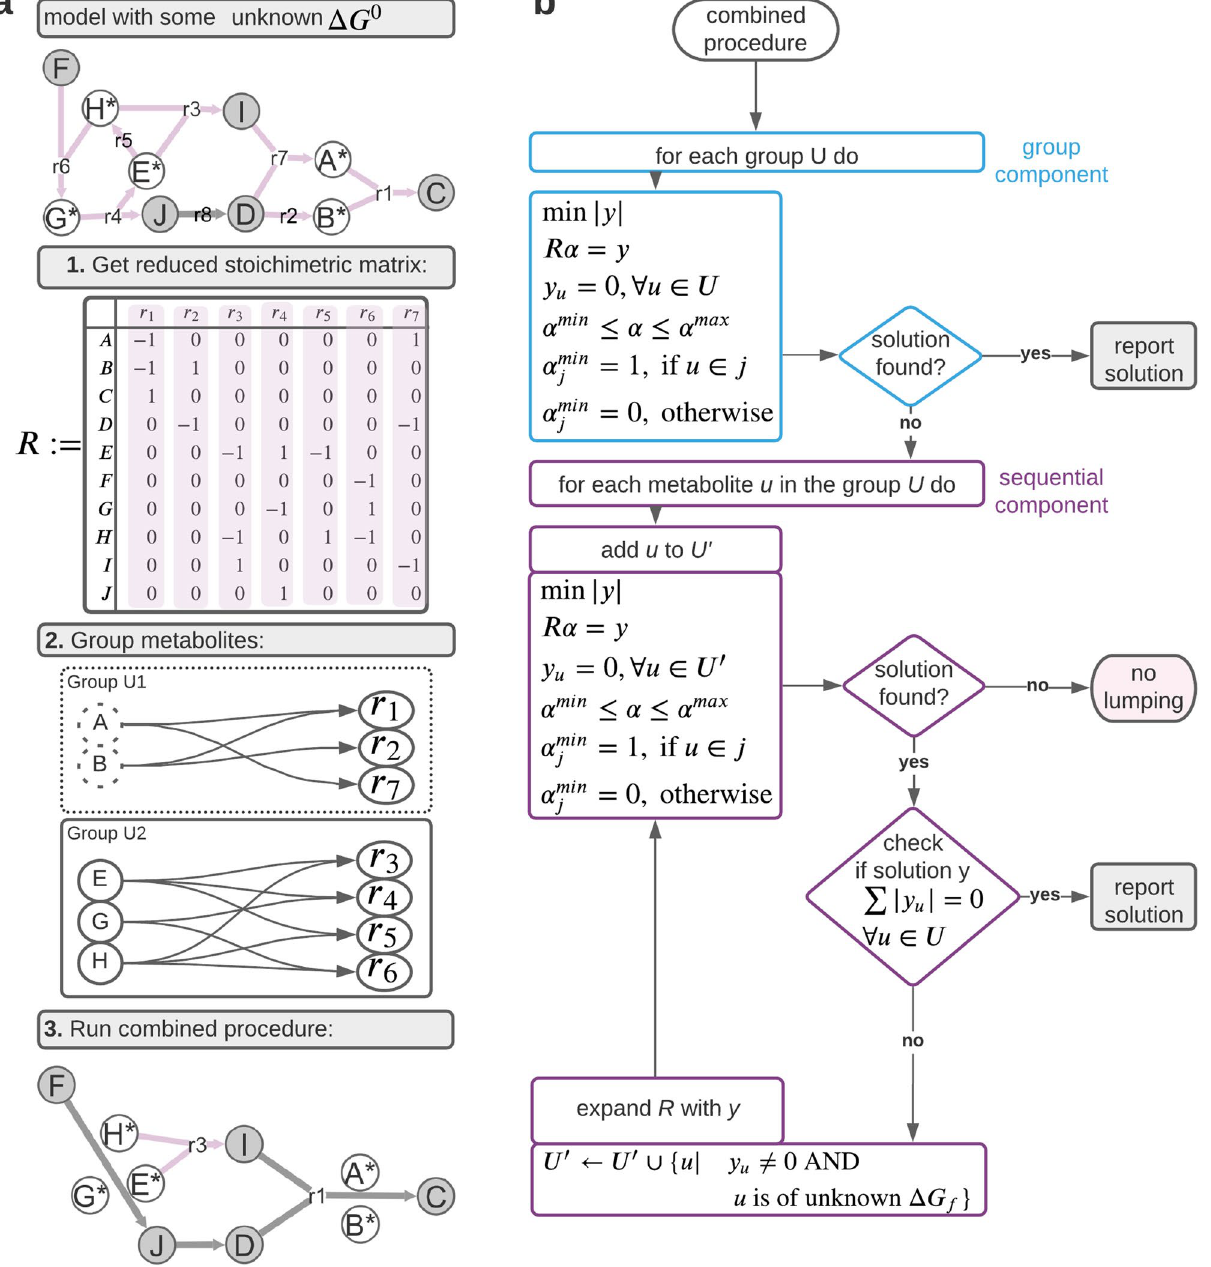
Figure 1. Reaction lumping workflow. Starting with a model involving reactions with unknown (cid:31) G 0 , a subset R of the underlying stoichiometric matrix is extracted involving only those. Then the lumping procedure identifies linear combinations of reactions to arrive at a lumped reaction whose (cid:31) G 0 can be calculated. ( a ) Proposed procedure identifies the reactions in R (pink shaded) based on the involvement of metabolites without 0 (here marked with *). In a second step, all metabolites with unknown ∆ 0 are partitioned based on ∆ f G f G shared appearance in at least one reaction. A group is defined as connected component within a bipartite graph having metabolite with unknown ∆ f G 0 . nodes and all reactions those metabolites participate in. Here, two groups, U1 and U2, are found. U1 consists of metabolites A and B , while U2 includes G , E and H . ( b ) The proposed procedure tests if all metabolites within a group can be eliminated at once; if no solution can be found each metabolite in the group is evaluated on its own. Each lution here is preliminary; it must be checked whether there are any other metabolites in the group still involved (which would hinder the (cid:31) G 0 calculation). If the latter hold true, such metabolites are added sequentially while each previous solution is placed in R